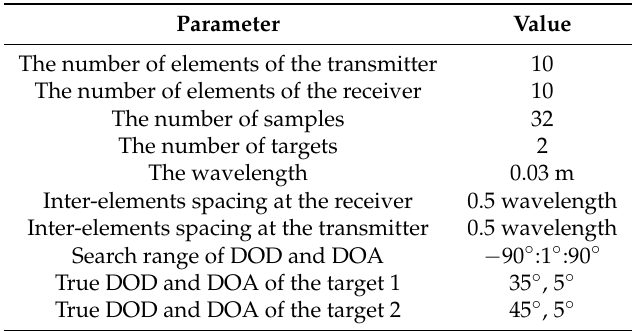
Table 3. Simulation parameters for two adjacent targets.